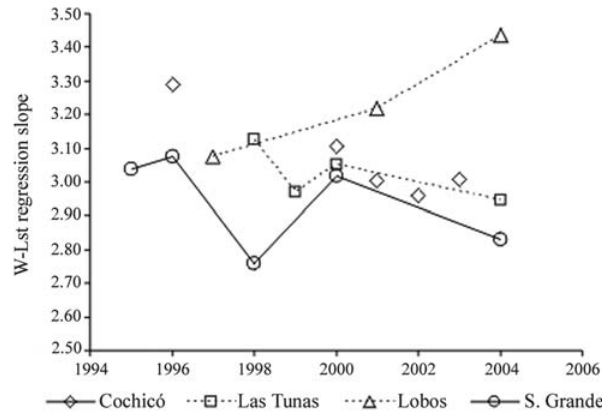
Fig. 6. Variability of weight-length regression slopes within lakes sampled at different years (adapted from Colautti et al ., 2006).